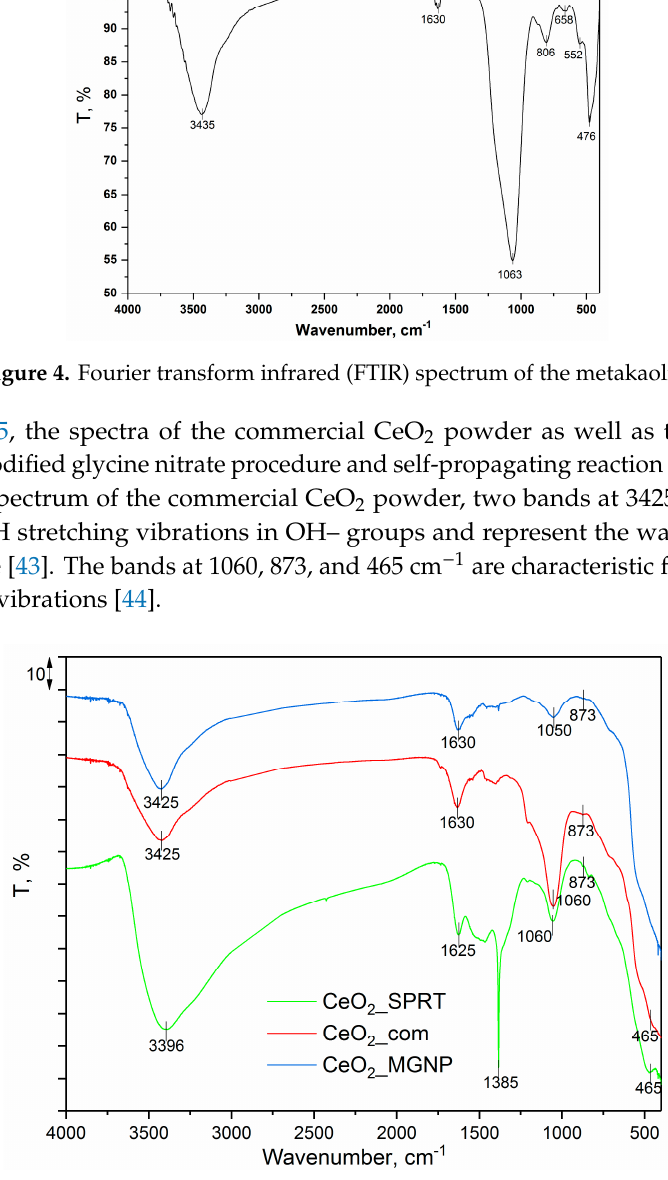
Figure 5. FTIR spectra of the CeO 2 _com, CeO 2 _MGNP, and CeO 2 _SPRT samples. MGNP: modified glycine nitrate procedure, SPRT: self-propagating reaction at room temperature.